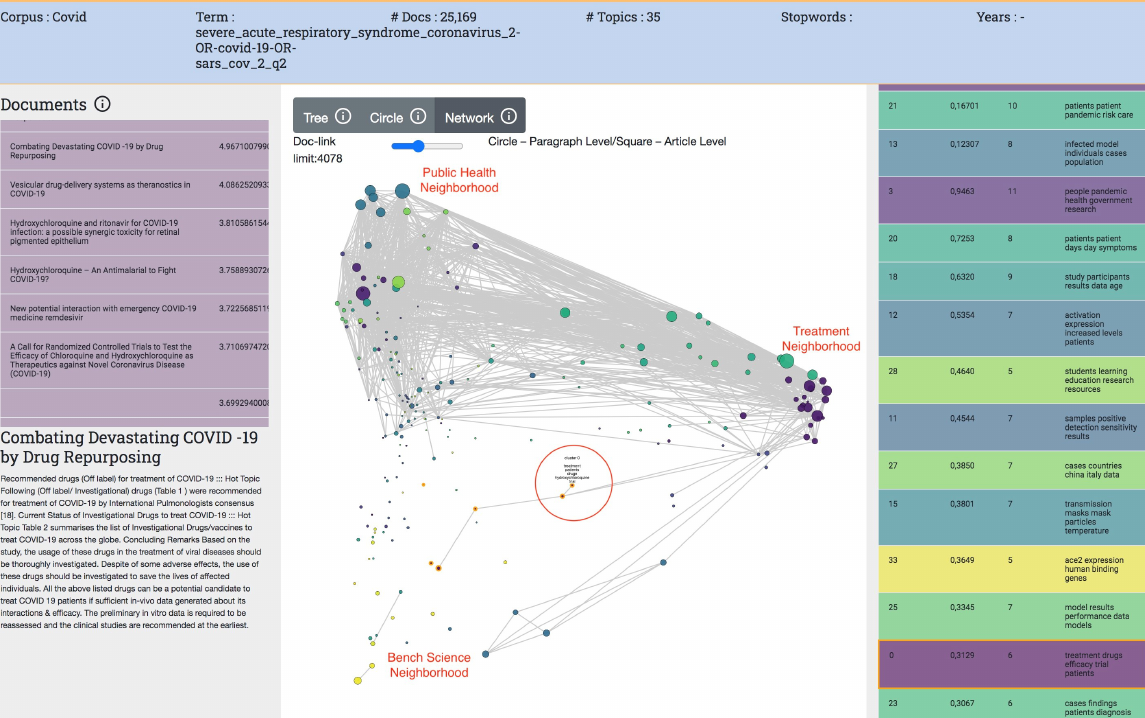
Figure 12. Network visualization of the COVID-19 Topic Model from